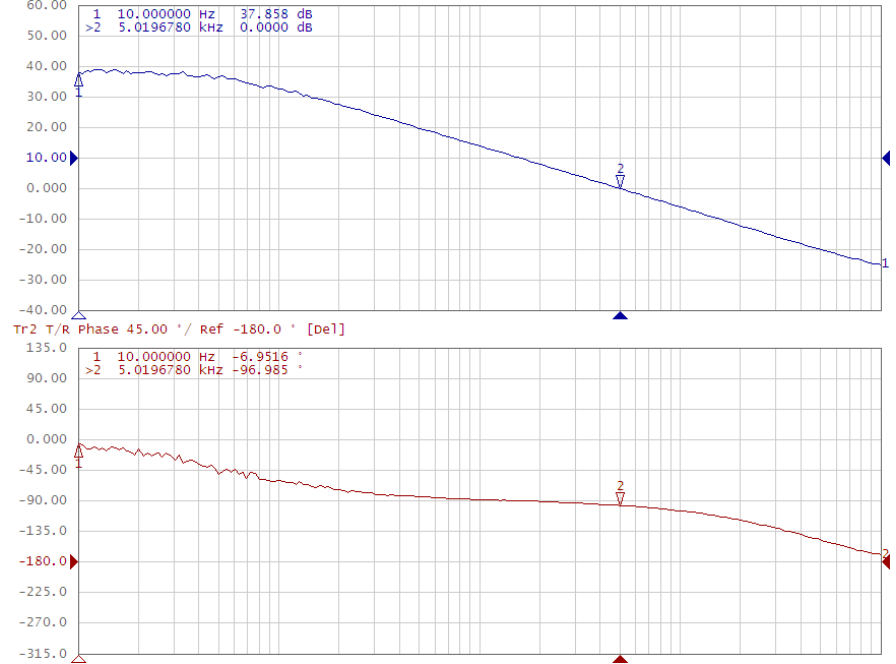
Figure 3. Measured open-loop AC response for C L = 150 pF.